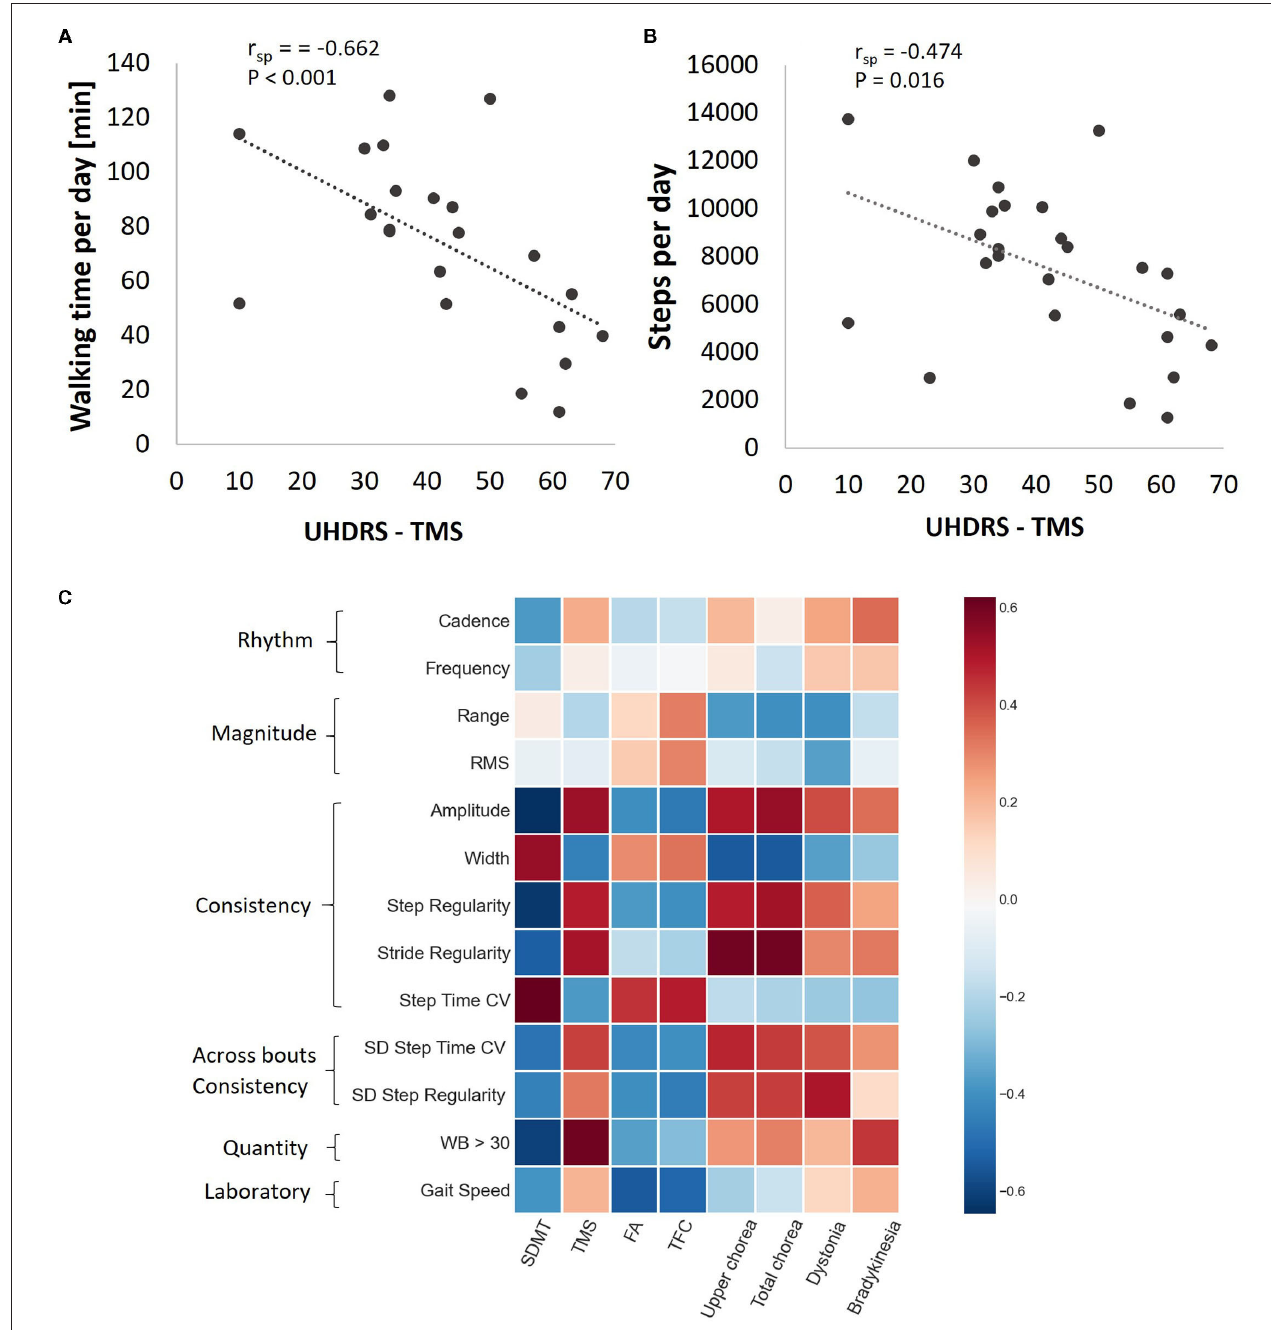
FIGURE 3 | Associations between daily-living measures and clinical measures among the HD participants. Walking time per day (A) and steps per day (B) as a function of TMS score. r sp , Spearman’s rank correlation coefficient after adjusting to age and gender. (C) Heat map showing the Spearman correlation coefficients between gait quality measures and HD clinical scores, after adjusting to age and gender. Darker pixels reflect higher correlation values. Note that while the rhythm measures tended to be only mildly correlated with the clinical measures, the consistency measures were generally more strongly correlated with the clinical